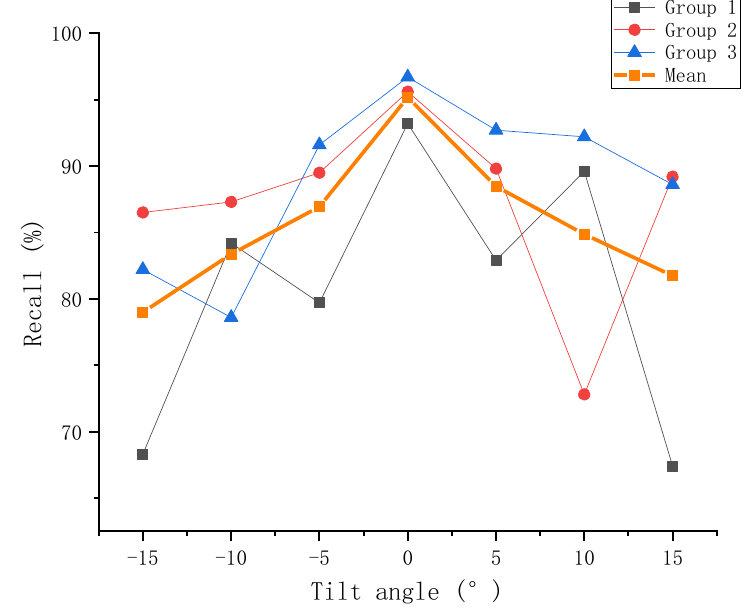
Figure 25. Recall of test samples with different tilt angle.